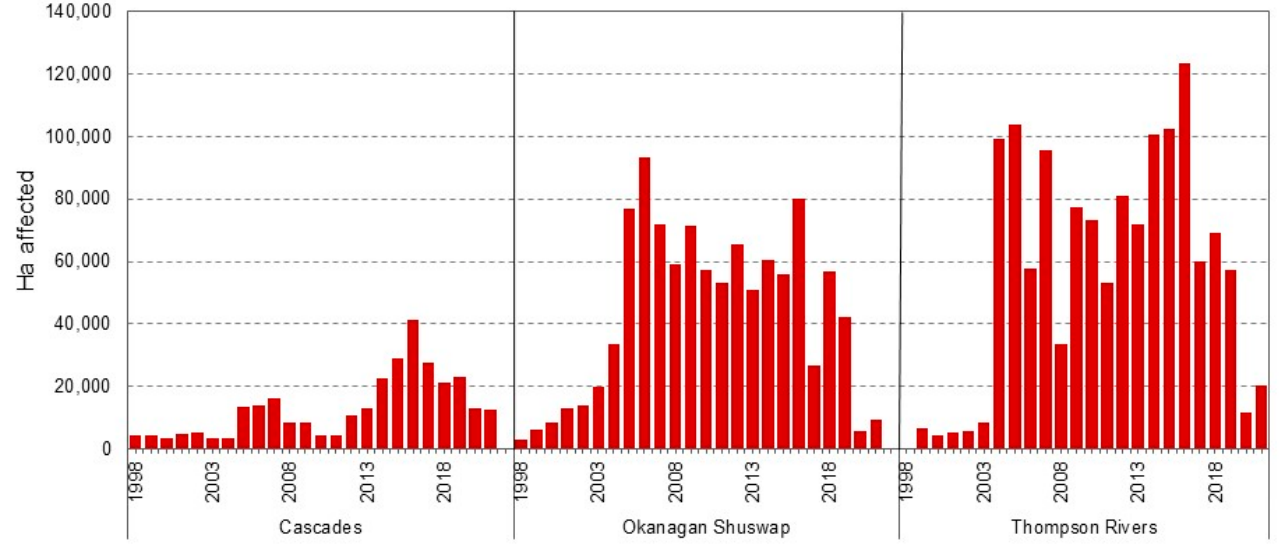
Figure 3. Red bars are the annual hectares (1998–2021) affected by D. confusus in the three forest districts in the Thompson Okanagan Region: Cascades District (Spius Creek-1 and 2); Okanagan Shuswap District (Scotch Creek, Sicamous Creek, Torrent Creek, Cherry Creek, Home Lake-1 and 2, Buck Mountain); and Thompson Rivers District (Raft River, Martin Creek).